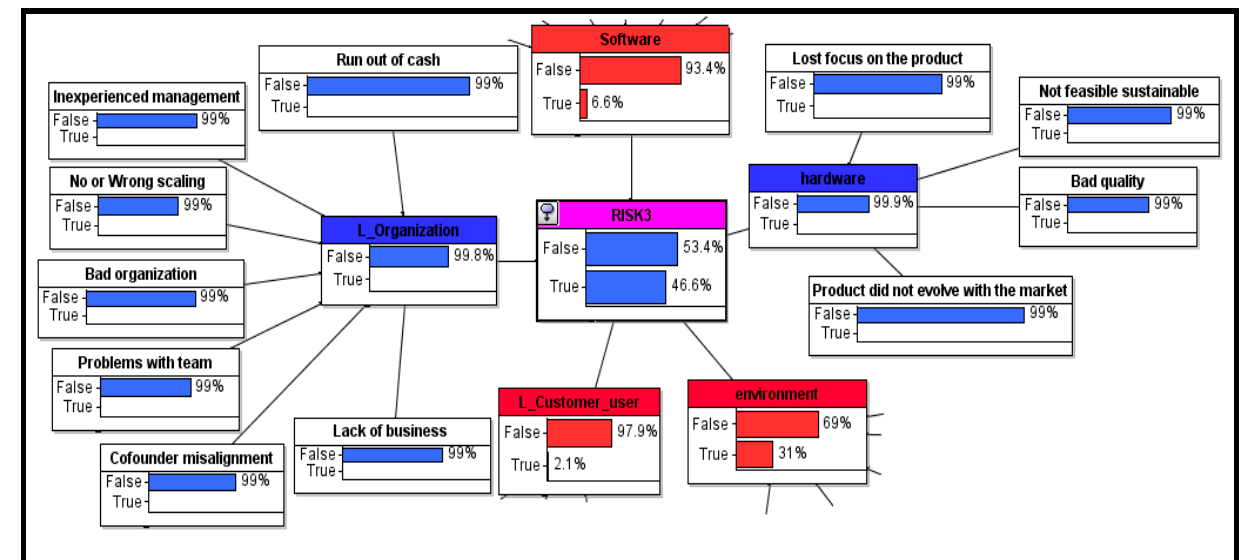
Figure 7. Back propagation BNs for start-up X .